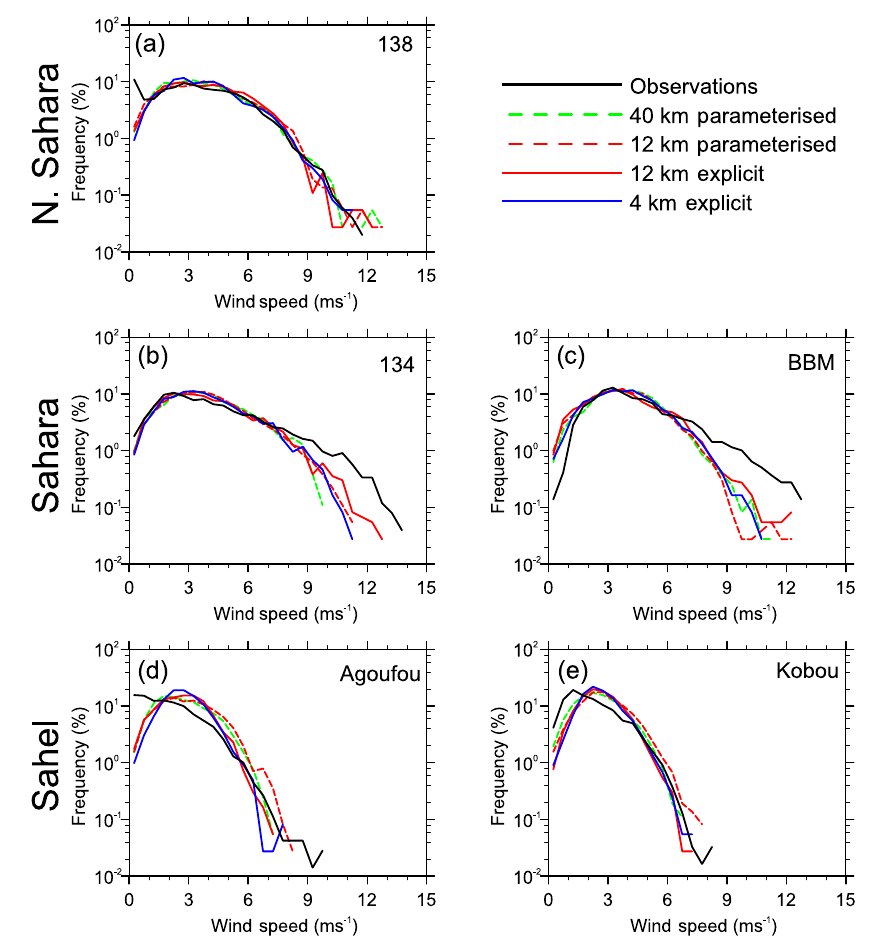
Figure 7. Probability density functions showing the frequency of wind speeds (adjusted to observation height) of different strengths for the observation stations and the closest simulated grid box. Rows indicate the box from Fig. 1 in which the stations are located. Black indicates observations and colours and dashed lines indicate grid spacing and representation of convection of the four